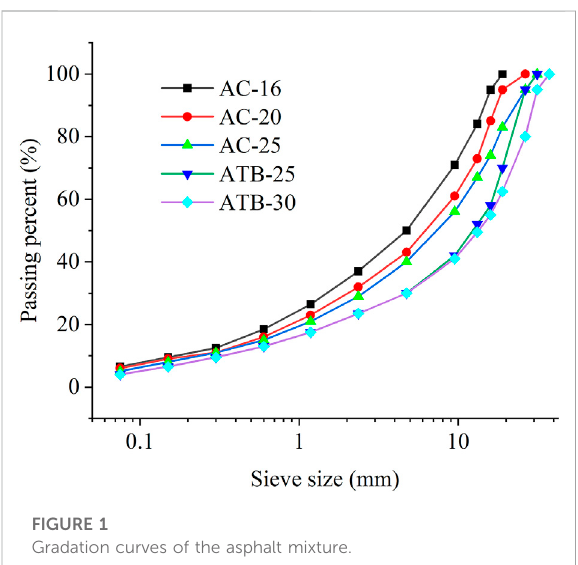
FIGURE 1 Gradation curves of the asphalt